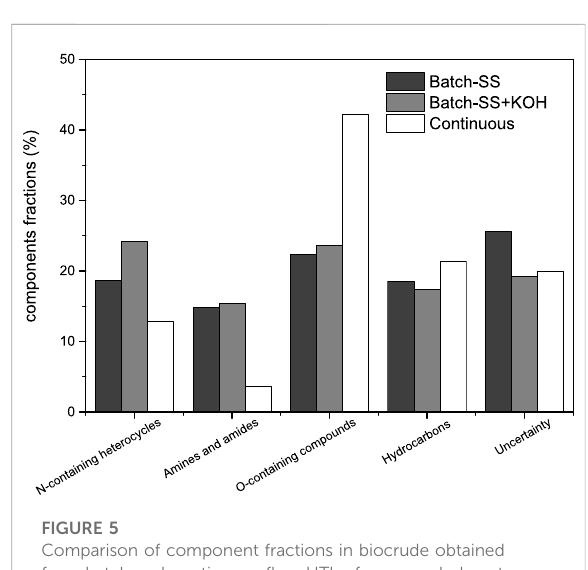
FIGURE 5 Comparison of component fractions in biocrude